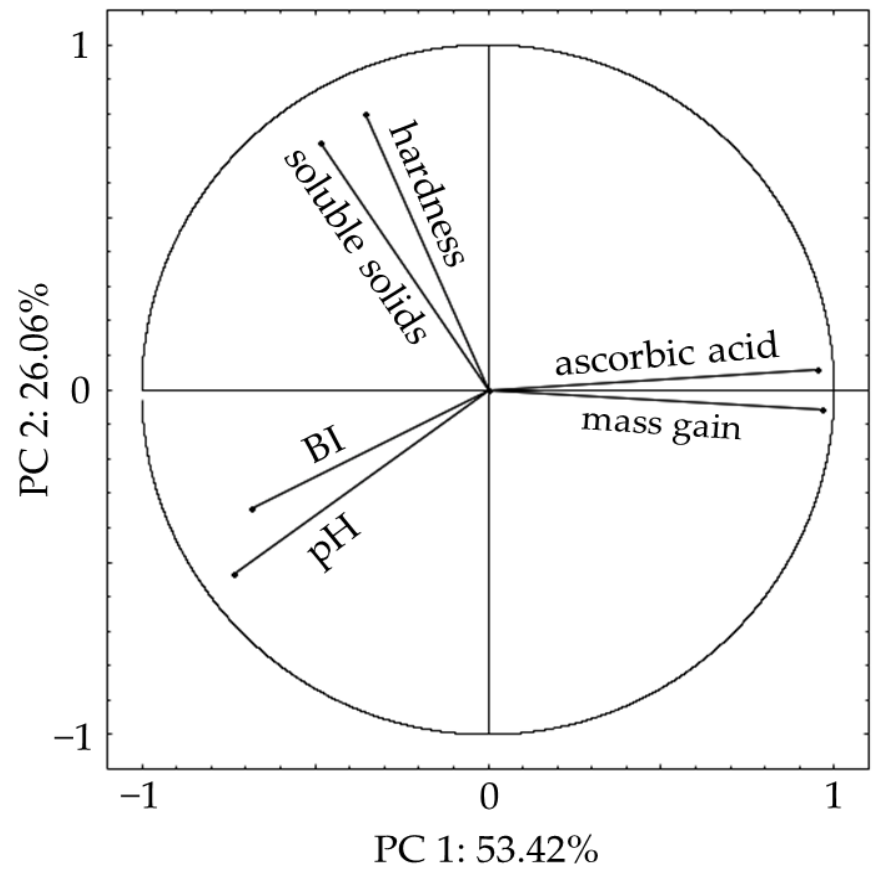
Figure 2. PCA loading plot.